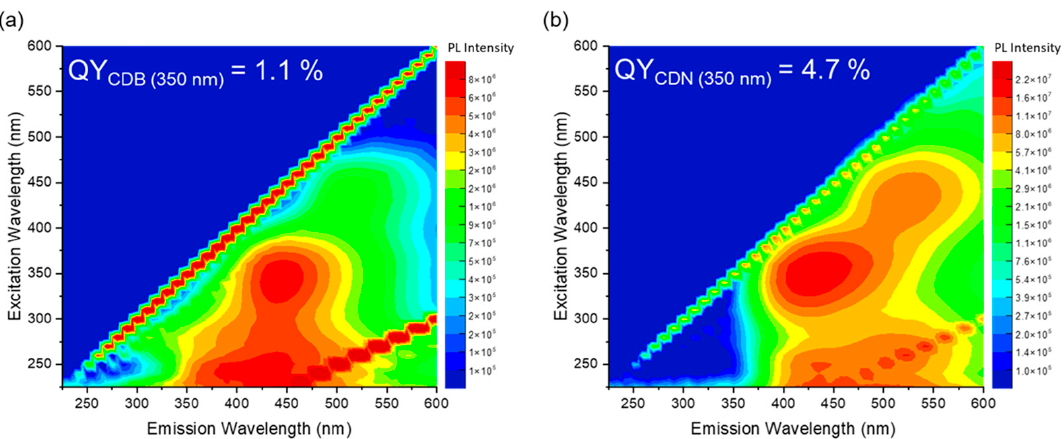
Figure 4. Excitation emission map of ( a ) CDB and ( b ) CDN samples.